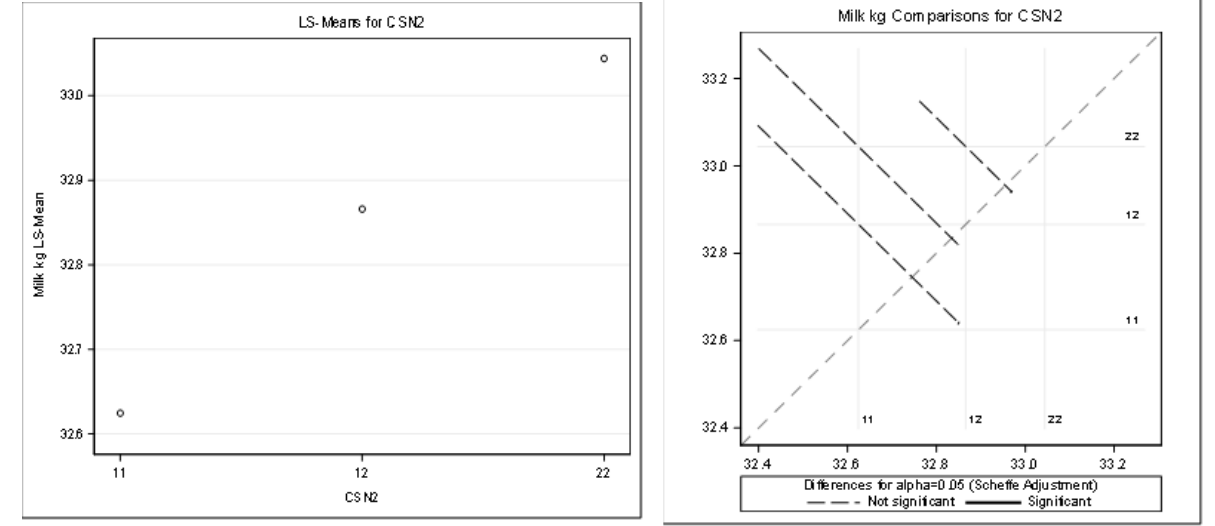
Table 10. Linear model (dependent variable: fat kg) .